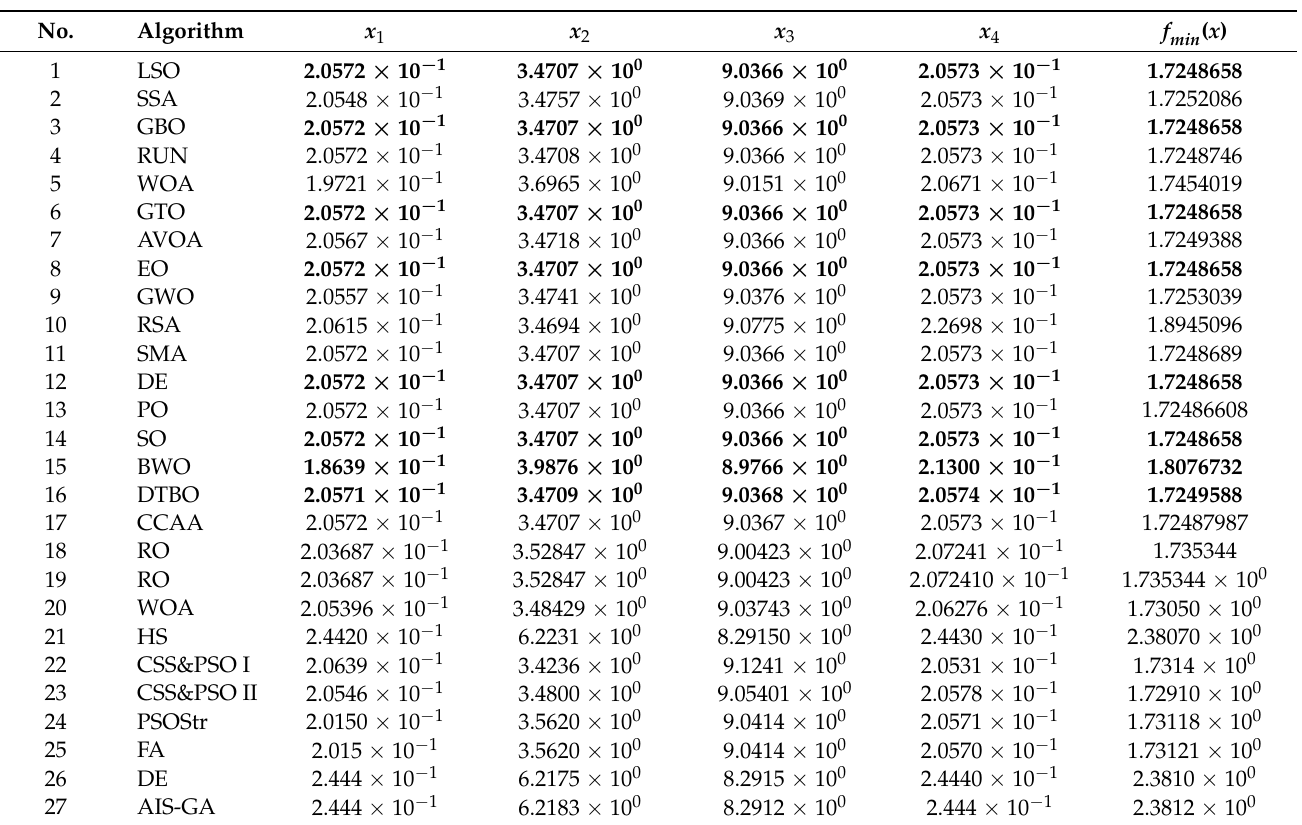
Table 18. Comparison of the results for weld beam design